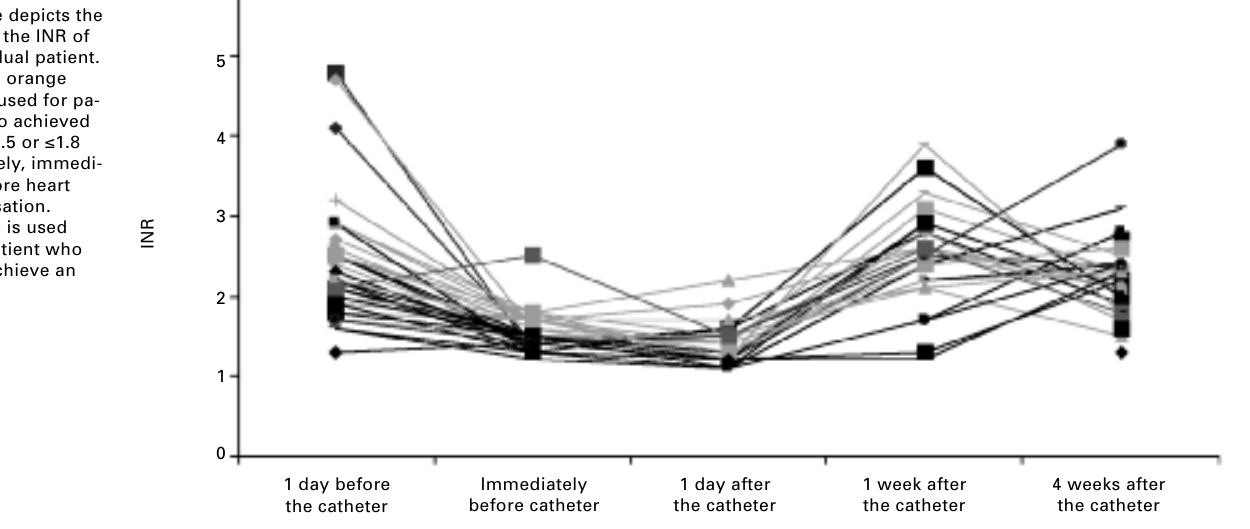
Every line depicts the course of the INR of an individual patient. Black and orange lines are used for pa- tients who achieved an INR ≤ 1.5 or ≤ 1.8 respectively, immedi- ately before heart catheterisation. A red line is used for the patient who did not achieve an INR ≤